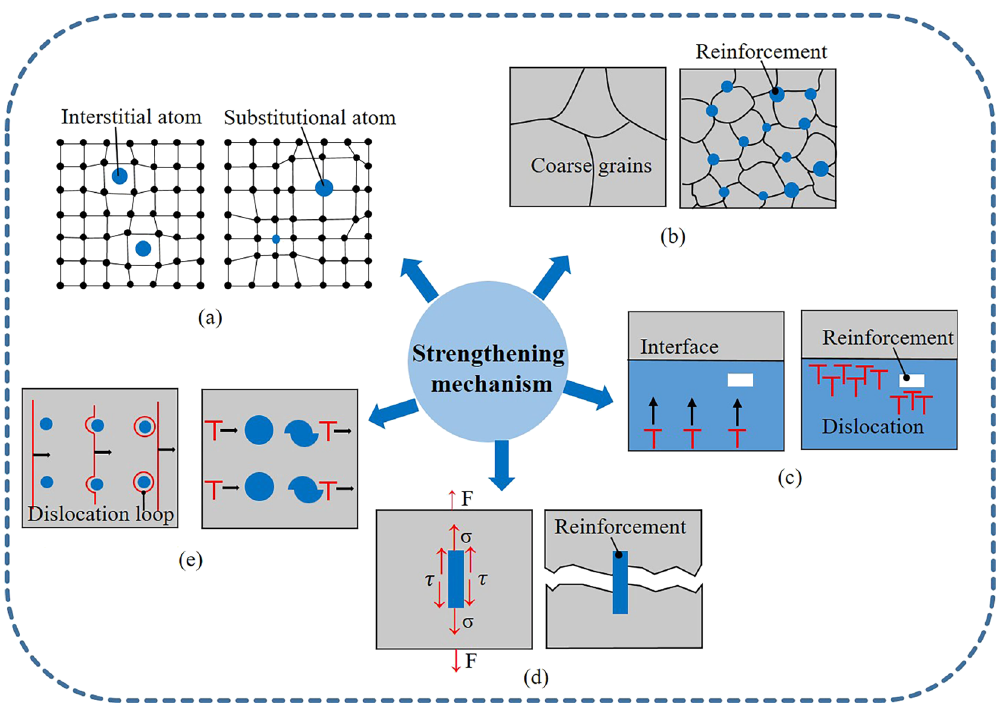
Figure 8: Schematic diagram of strengthening mechanism of HEAs, ( a ) solution strengthening, ( b ) fi ne grain strengthening, ( c ) dislocation strengthening, ( d ) load transferring, and ( e ) dispersion